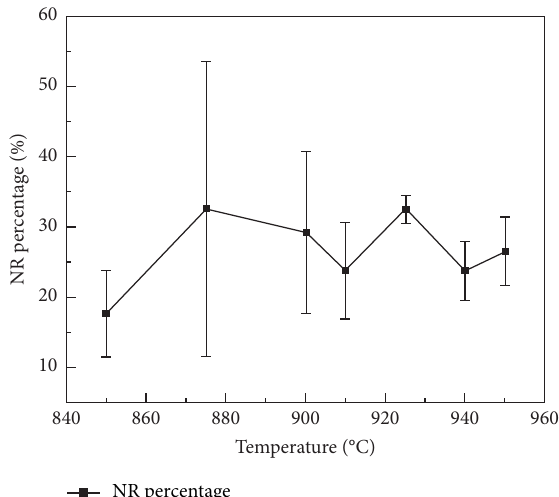
Figure 14: The average NR percentage of specimens at different RHT conditions.